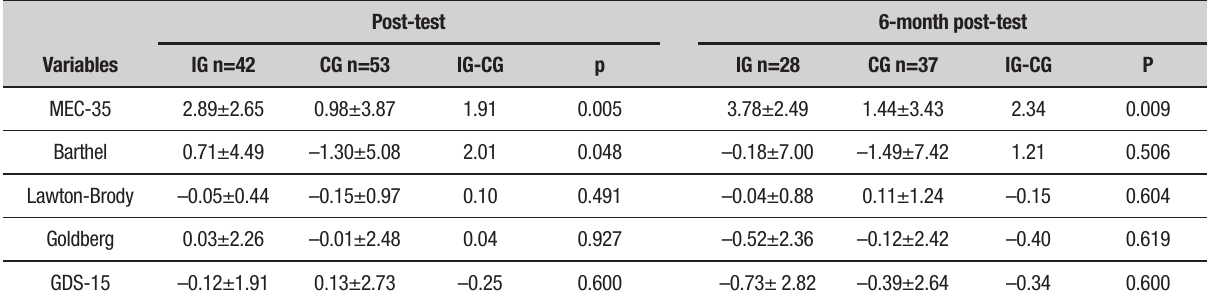
Table 3. Mean±SD of increases in outcome variables relative to baseline